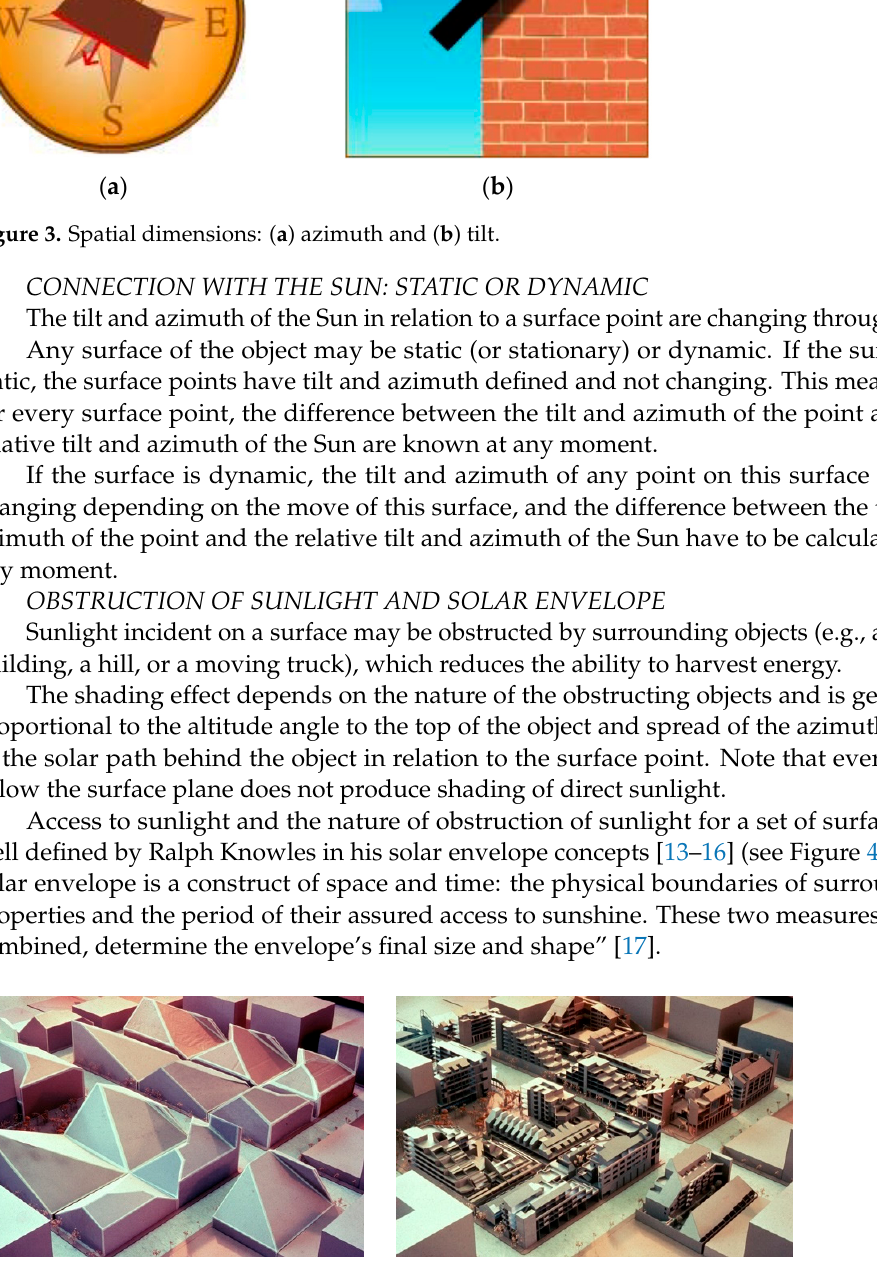
8 Figure 2. Diversity of surfaces: residential house roof. SPATIAL DIMENSIONS •